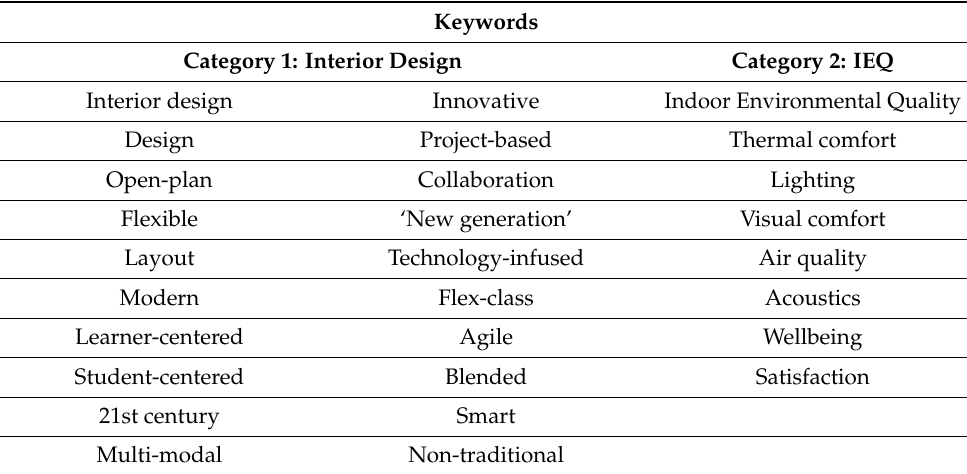
Table 1. Keywords and categories used in the search